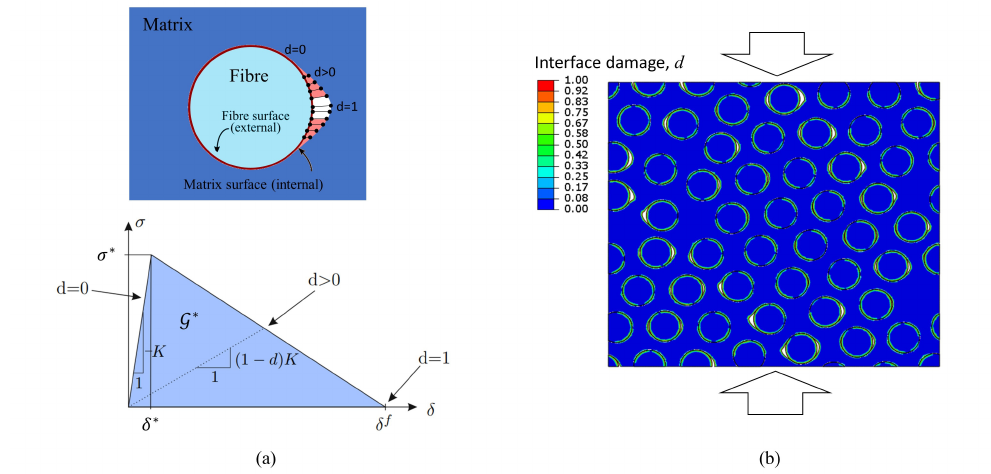
Figure 14. ( a ) Traction-separation response at the interacting surfaces of the fibre–matrix interface. ( b ) Multiple fibre debonding taking place under compression in a RVE with 50 fibres (scale factor